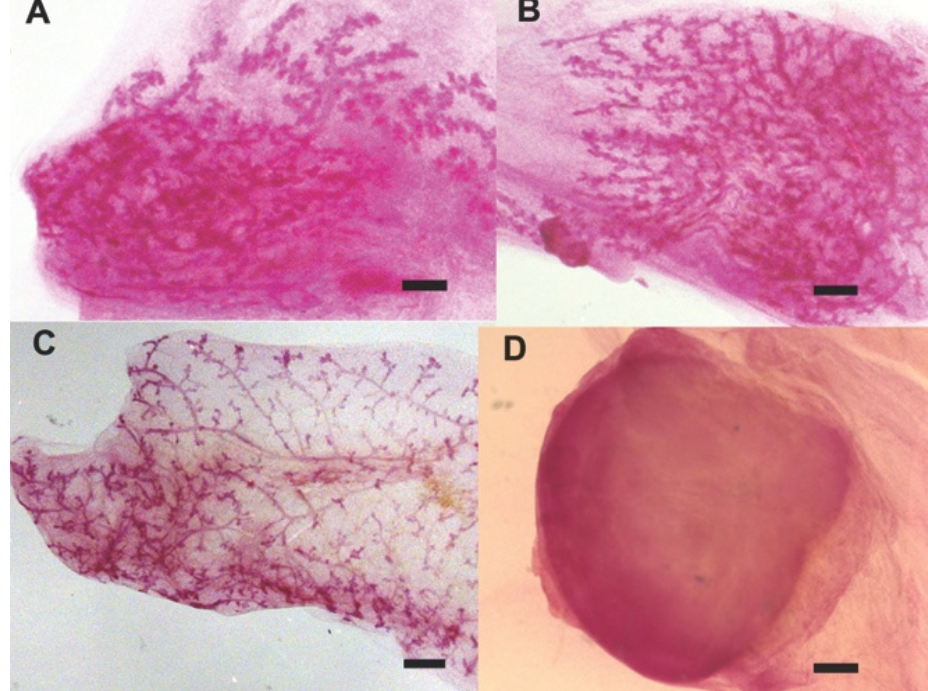
Figure 1. Tumor-free chimeric (human-mouse) mammary gland outgrowths . A-B) Representative whole mounted tumor-free mouse mammary outgrowths generated from the inoculation of both human embryonal carcinoma cells (NT2) and mammary epithelial